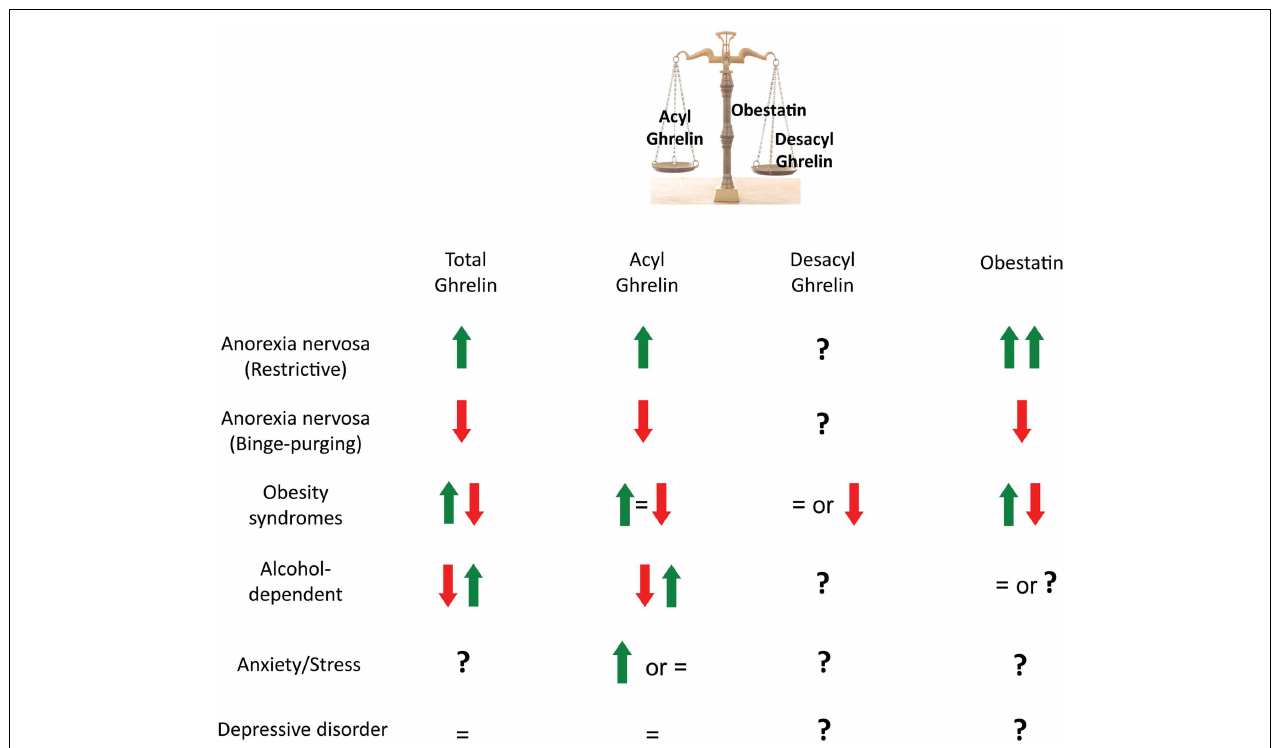
either reduced or increased compared to healthy subjects but there might be differences in gender, body mass index, nutritional/metabolic status and/or time after alcohol withdrawal from one study to another that can explain the contradictory results. In major depressive disorders, the majority of studies report no differences in plasma total or acyl ghrelin levels compared with healthy controls.Whether ghrelin can contribute to the degree of food craving, alcohol craving or depression is not clearly demonstrated as treatments and metabolic modifications can interfere with the